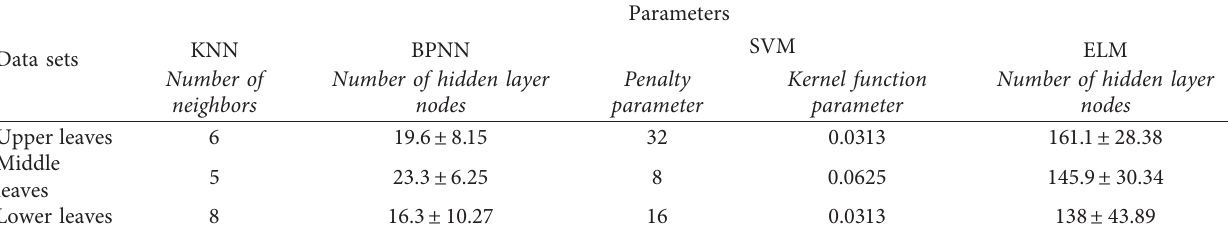
Table 7: The optimal parameters for KNN, BPNN, SVM, and ELM. Data